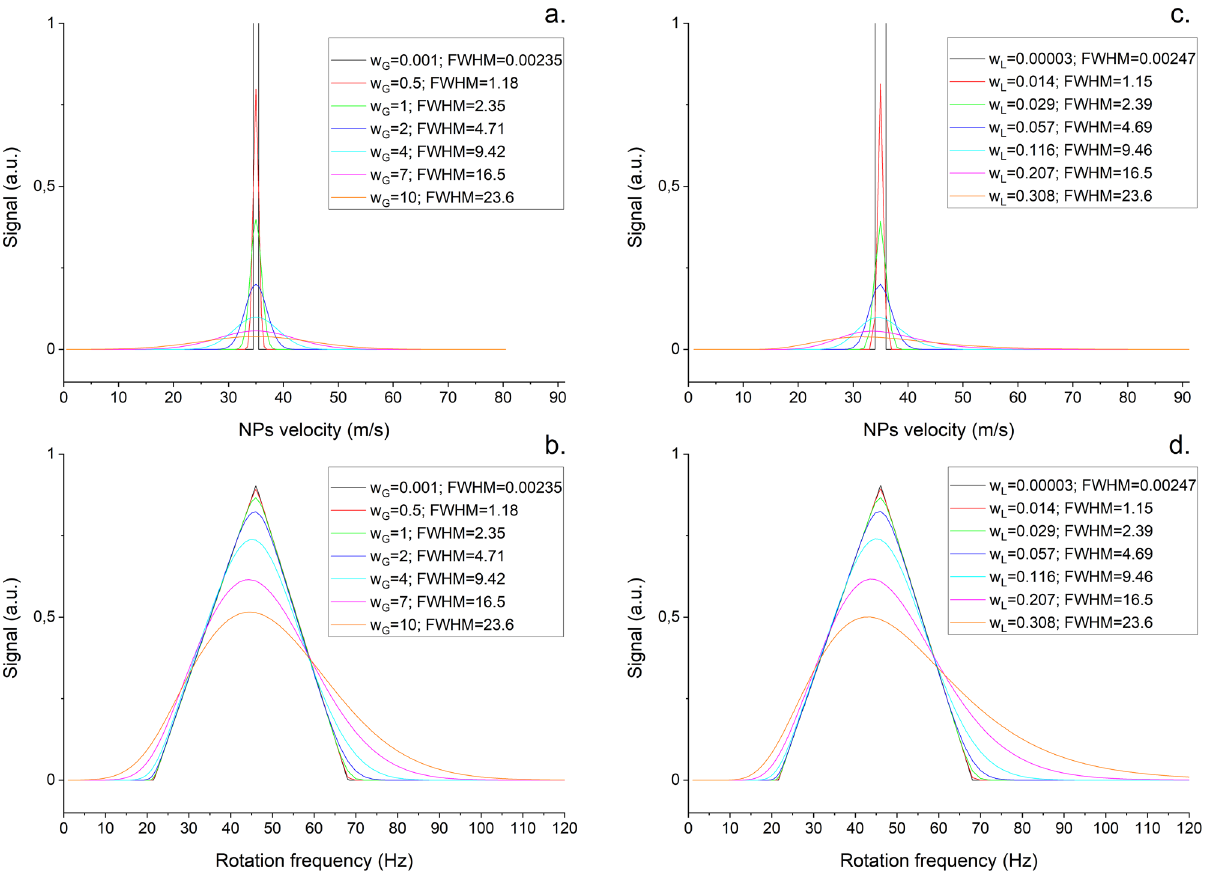
Figure 5. ( a ) Gaussian velocity distributions; ( b ) Simulation of the signals obtained from 5° disks for Gaussian velocity distributions; ( c ) log-normal velocity distributions. ( d ) simulation of the signals obtained from 5° disks for log-normal velocity distributions.